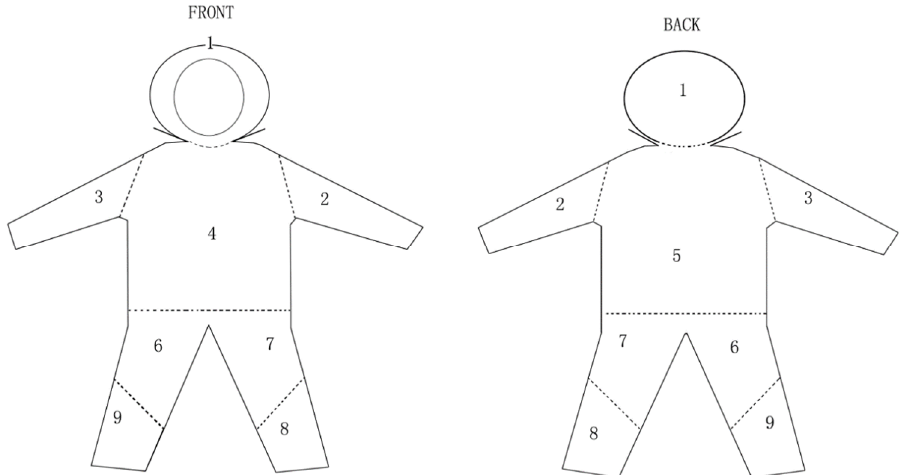
Figure 2. Coverall sectioning for whole-body dosimetry analysis. 1: head, 2: left arm, 3: right arm, 4: chest, 5: back, 6: right thigh, 7: left thigh, 8: left leg, 9: right leg.